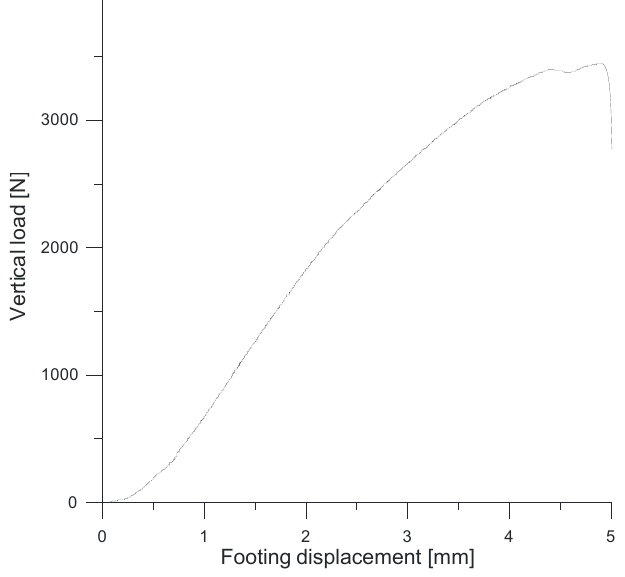
Figure 7. Load vs. footing displacement.